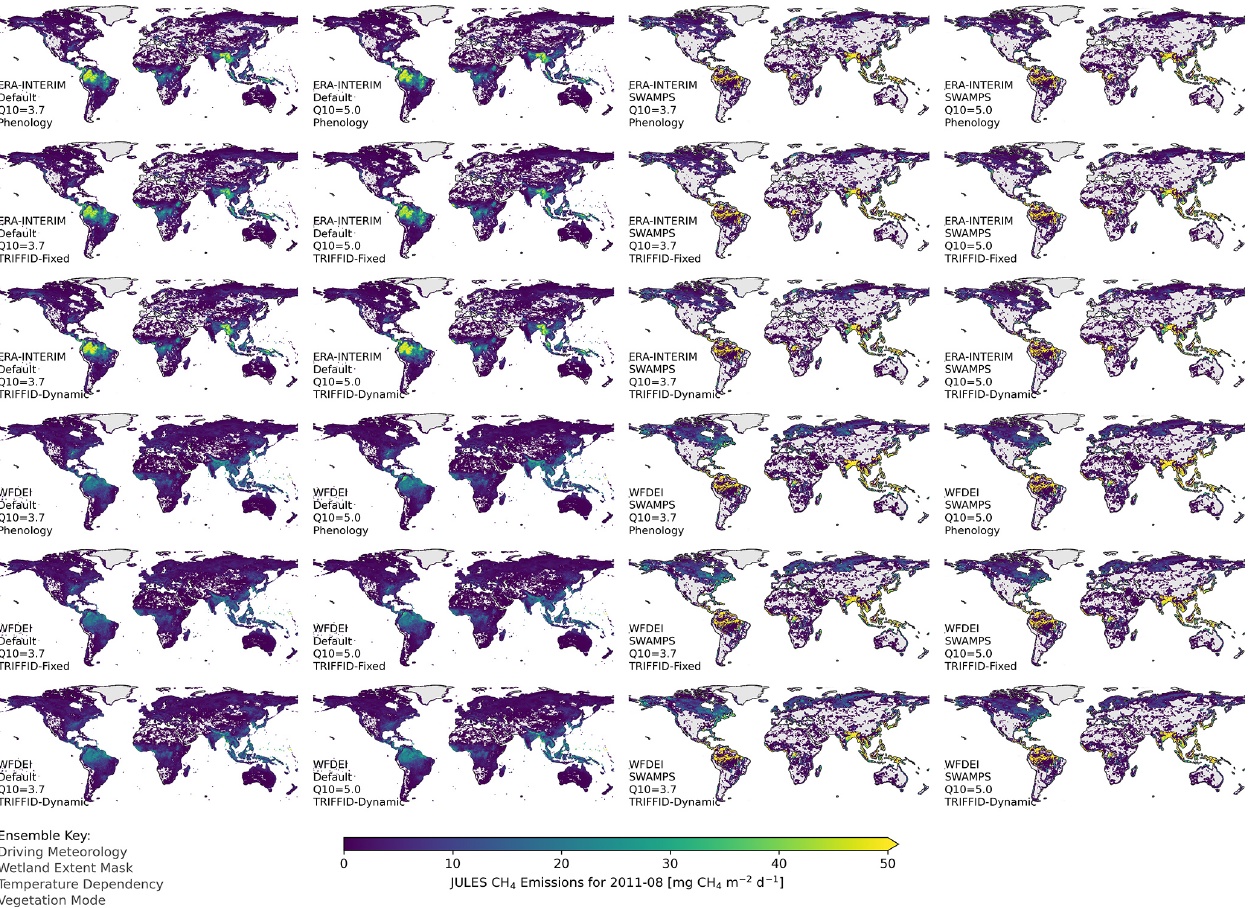
Figure 2. Example (August 2011) of wetland CH 4 emissions generated from each JULES ensemble members used in this study. The ensem- ble comprises two meteorological driving data configurations, two wetland extent configurations, two temperature dependency configurations and three vegetation configurations. Each panel is labelled with the details of its configuration, following the format of the key (shown in the bottom